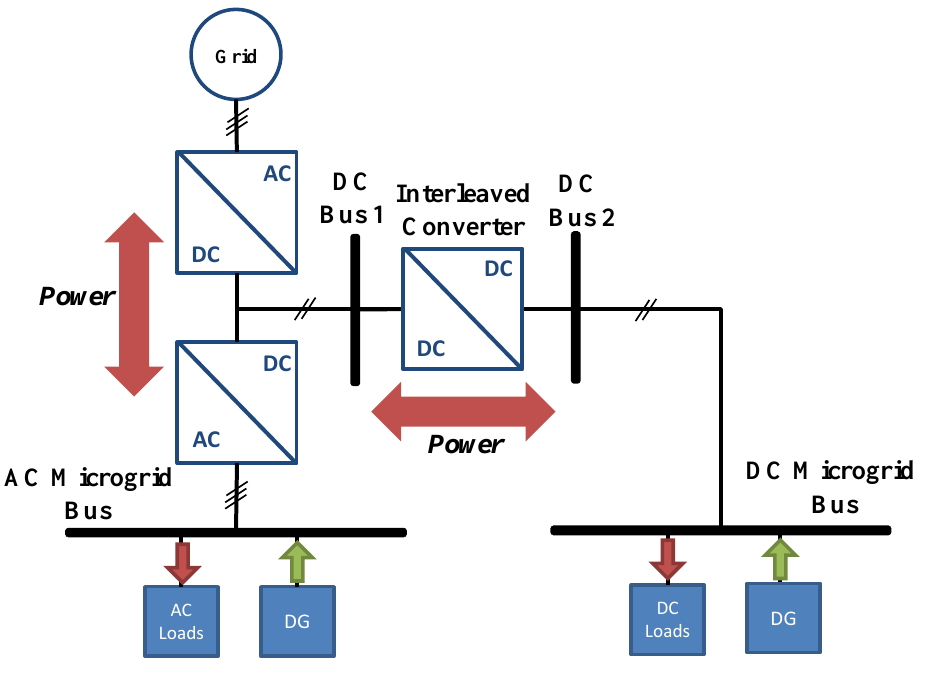
Figure 13. Topology implemented in PSCAD/EMTDC with a complete hybrid microgrid operating with bidirectional power flow between the AC microgrid and main grid and between the DC microgrid and the rest of the